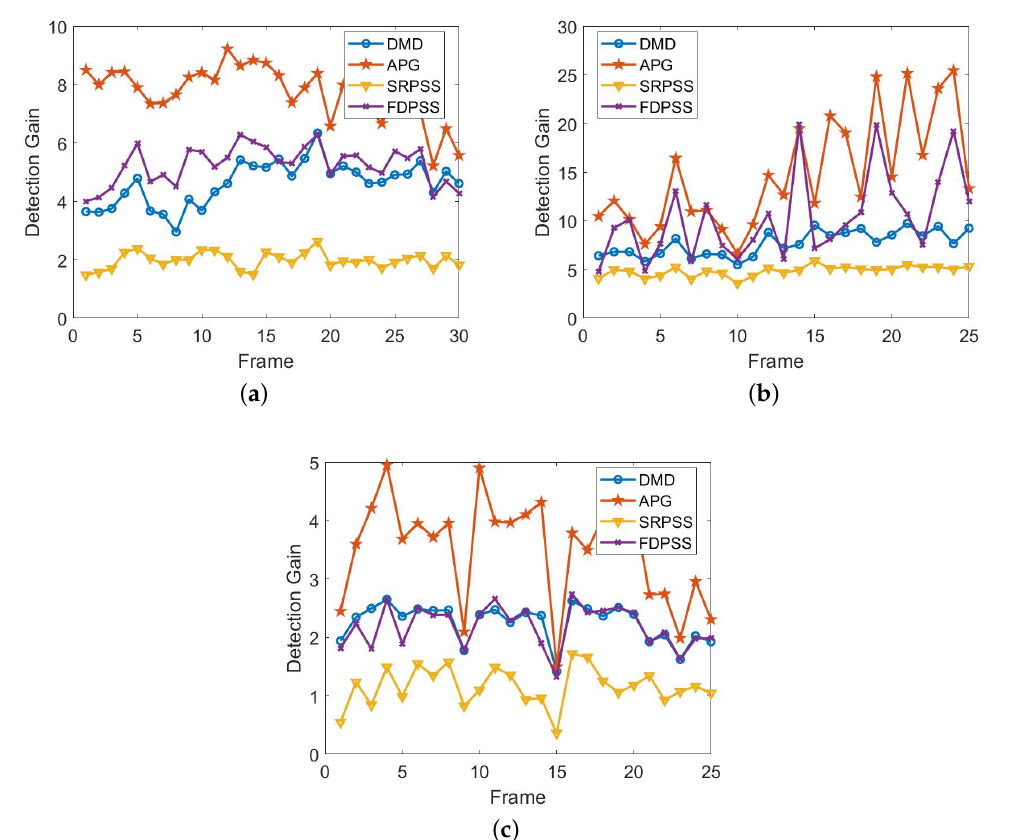
Figure 4. Results of detection gain. ( a ) is the result of the first set of data; ( b ) is the result of the second set of data; ( c ) is the result of the third set of